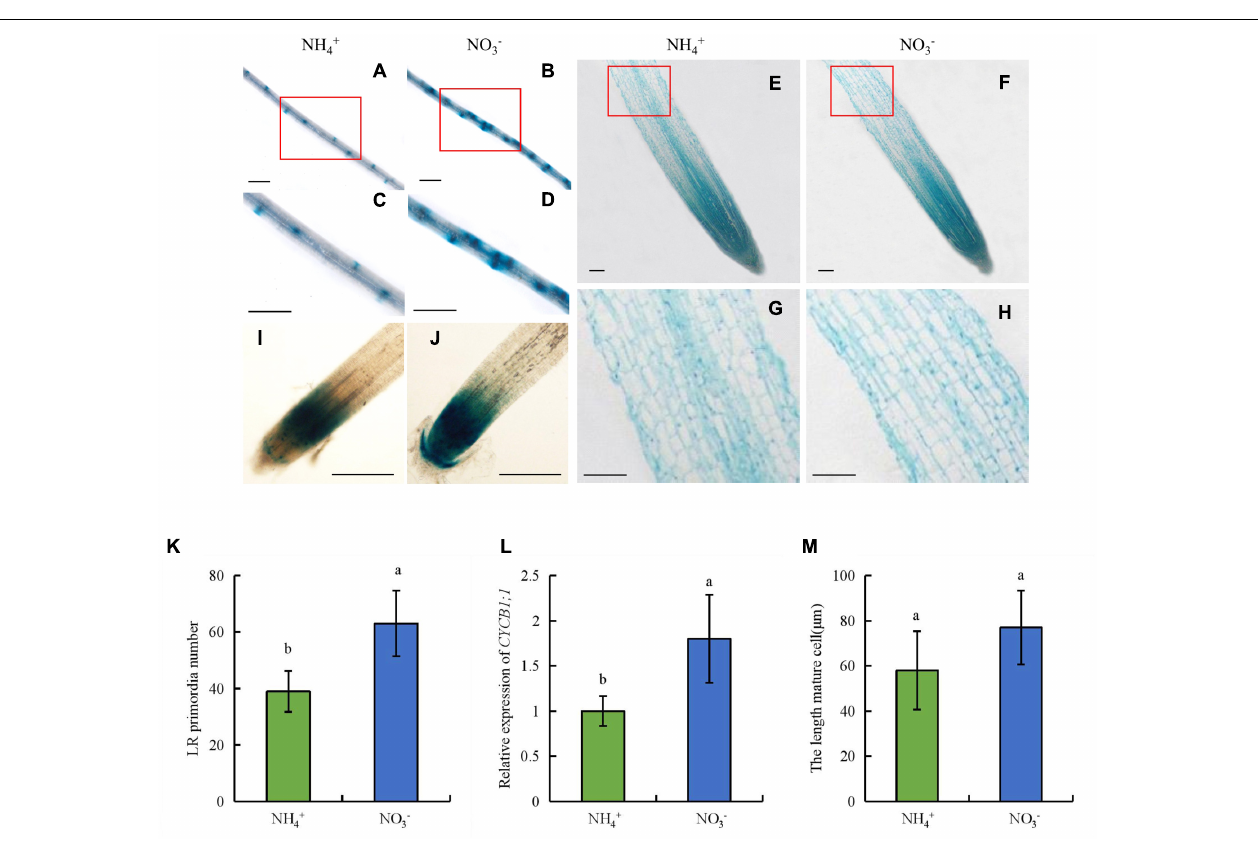
FIGURE 9 | Histochemical localization of DR5::GUS activity and [ 3 H]IAA transport in wild-type (DJ). Seedlings were grown in a hydroponic media containing NH 4 + and NO 3 − in addition to SNP (10 µ M) and cPTIO (80 µ M) for 14 days. (A) , DR5::GUS , a specific reporter that contains seven repeats of a highly active synthetic auxin response element and can reflect the in vivo auxin level. Roots were stained for GUS activity for 2 h at 37 ◦ C; (B) , [ 3 H] IAA activity in root tip (RT) and lateral root zone (LR). Data are means ± SE and bars with different letters indicate significant difference at P < 0.05 tested with ANOVA.